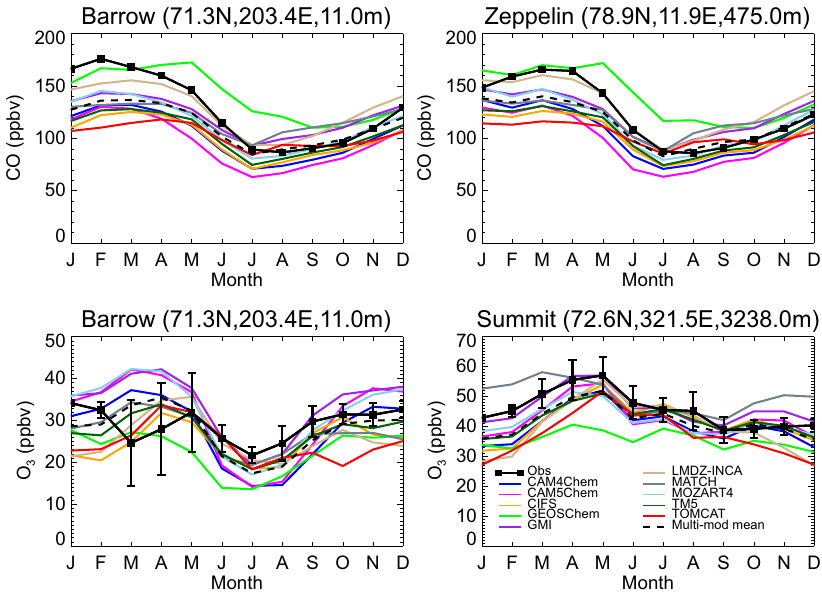
Figure 2. Monthly mean 2008 simulated and observed Arctic surface CO (top) at Barrow and Zeppelin and surface O 3 (bottom) at Barrow and Summit. Errors bars show 1 σ of the daily observed O 3